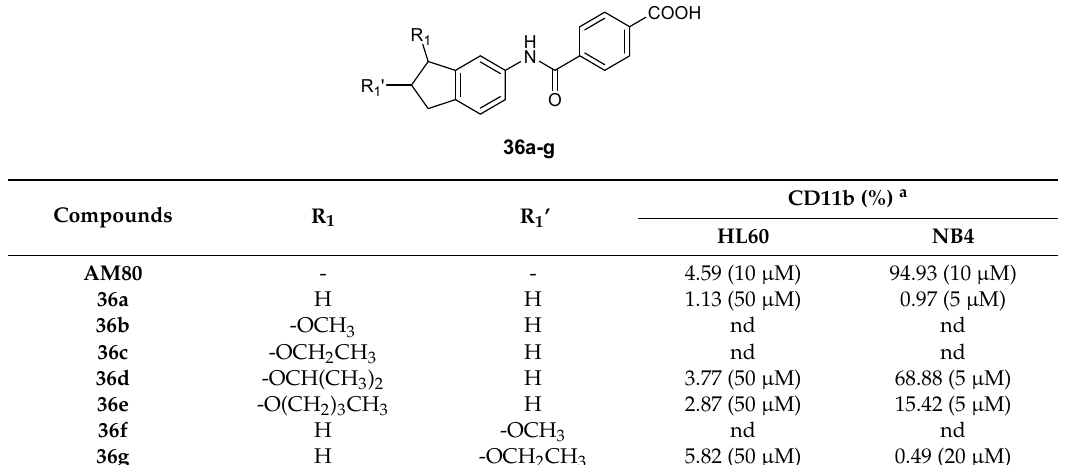
Table 3. Cell differentiation potential of compounds 36a – g . Table3. Cell differentiation potential of compounds 36a – g